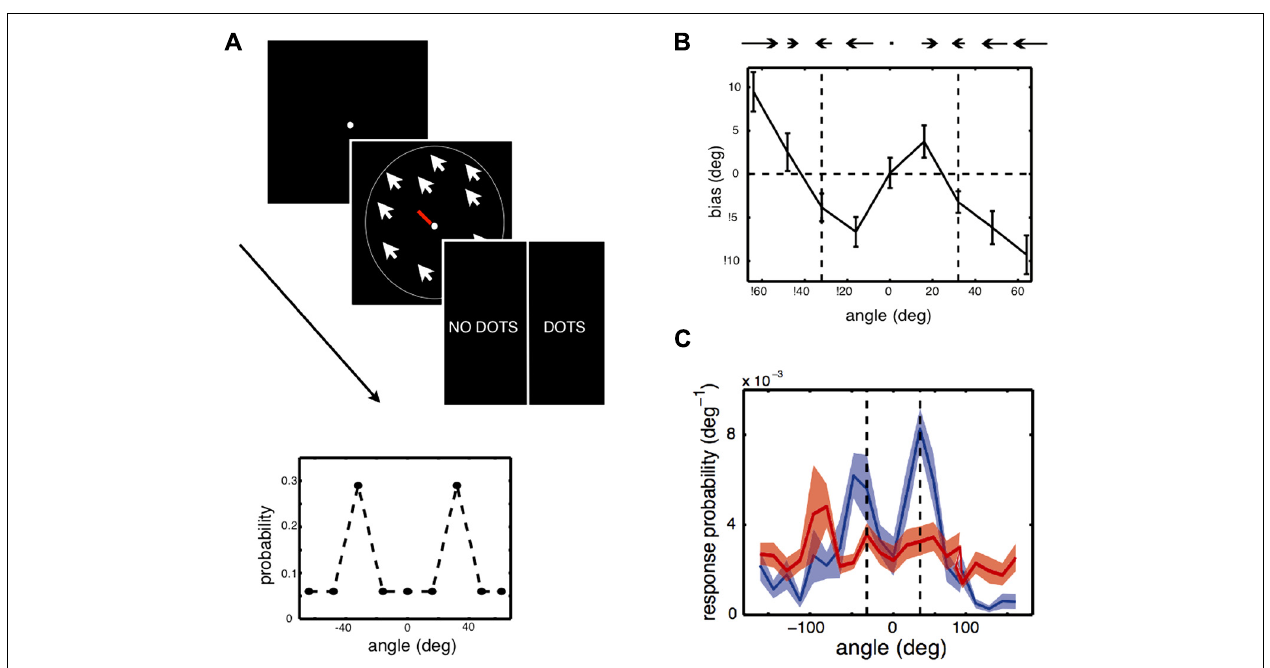
FIGURE 2 | Experiment and main results of Chalk etal. (2010). (A) Stimulus and task used in the experiment. In each trial, participants were asked to give an estimate of the direction of motion of a cloud of coherently moving dots by moving the central bar (estimation task), then indicate whether they had perceived a stimulus or not, by clicking on “dots” or “no dots” (detection task). Some trials had very low contrast stimuli or no stimuli at all. Feedback was only given relative to the detection task. Inset: Two directions of motion, − 32 ◦ and 32 ◦ , were presented in more trials than other directions. The question was